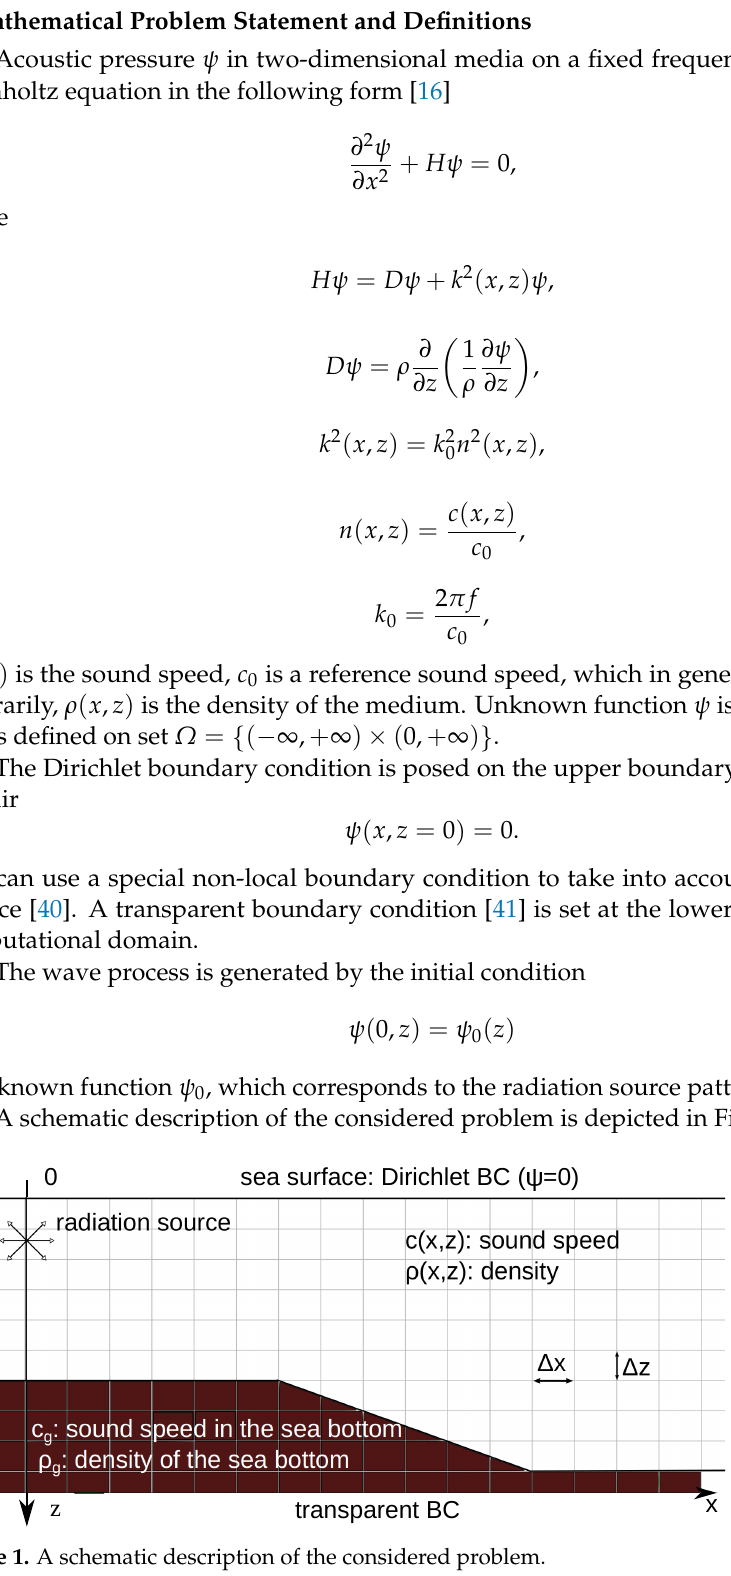
Figure 1. A schematic description of the considered problem. Using the change of variable